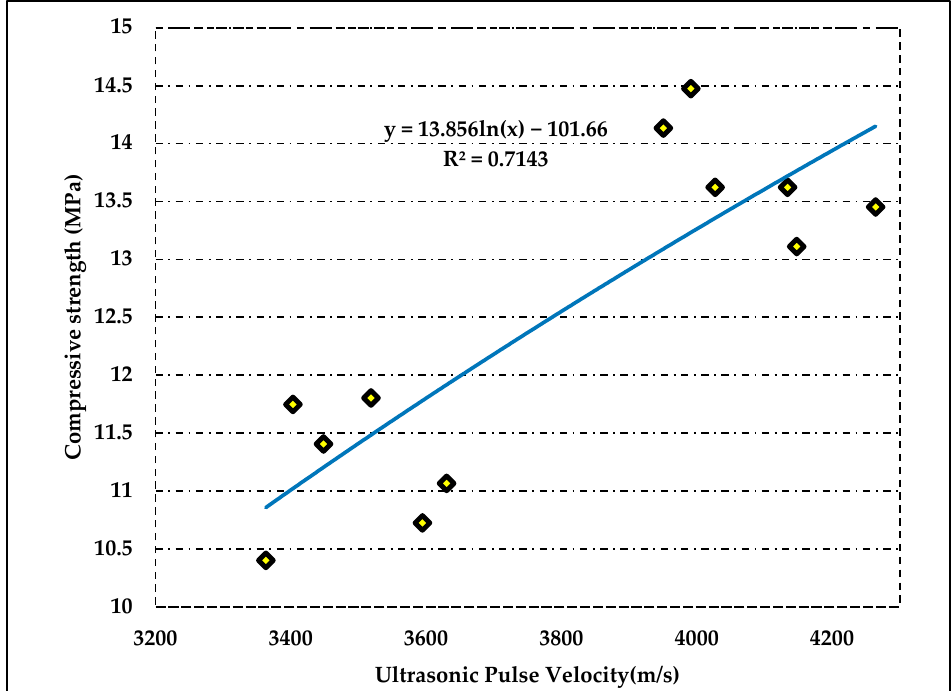
Figure 10. Regression analysis between destructive and non-destructive testing.